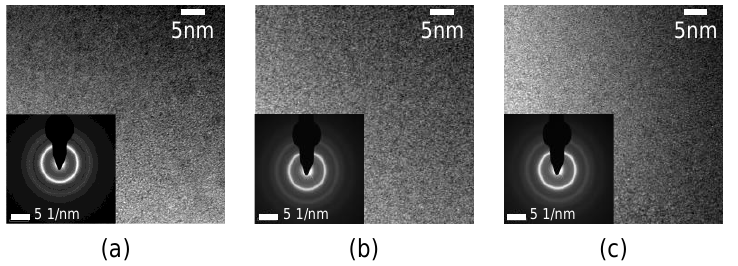
Figure 8. TEM images and selected area diffraction patterns of AA samples. ( a ) HRTEM and SAED of the original ribbon, ( b ) HRTEM and SAED of the centre on the processed sample. ( c ) HRTEM and SAED of the cut edge on the processed